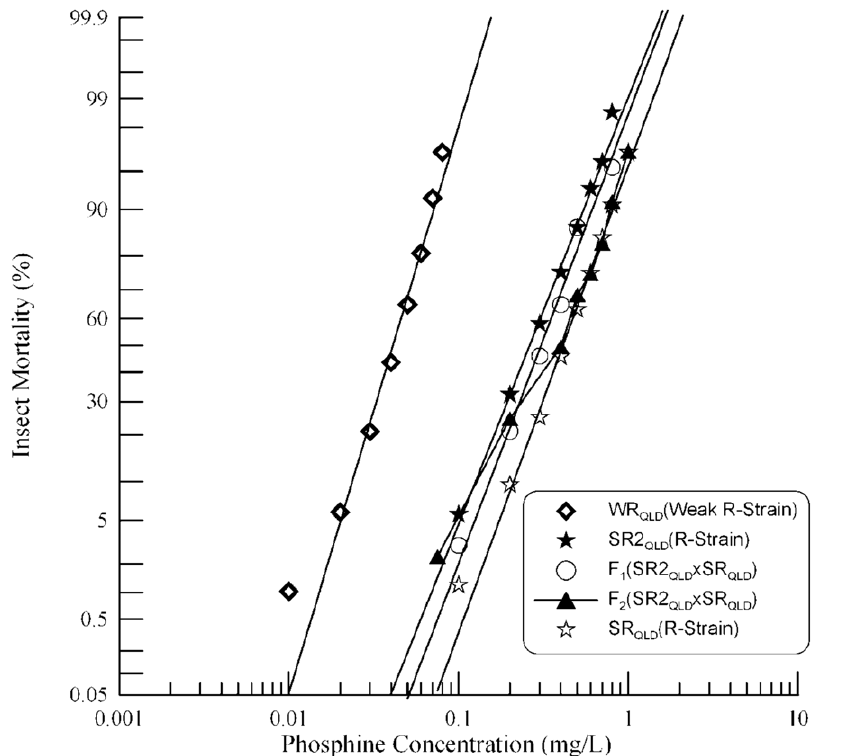
Figure 5. Resistance response of F 1 hybrids and F 2 progeny of a cross between two strongly resistant R.dominica strains from Queensland. Results are presented as log-dose mortality of the F 1 hybrids and the F 2 progeny with reference curves of the parental strains, SR2 QLD (R-Strain 2) and SR QLD (R-Strain 1), and the weakly resistant strain from Queensland (WR QLD ). Phosphine exposure was for 48 hours at 25 u C and 70% r.h.